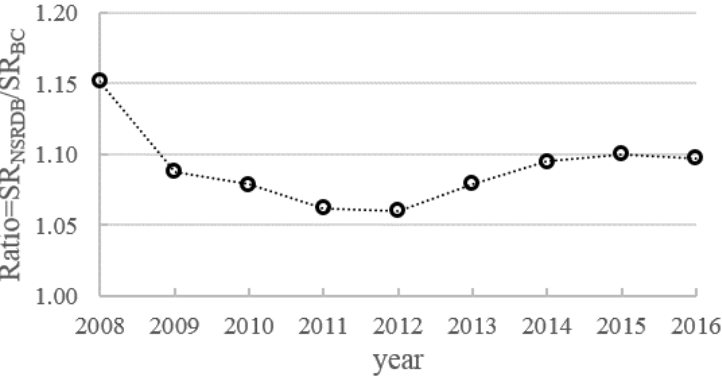
Figure 3. The ratios of SR NSRDB /SR BC from 2008 to 2016.